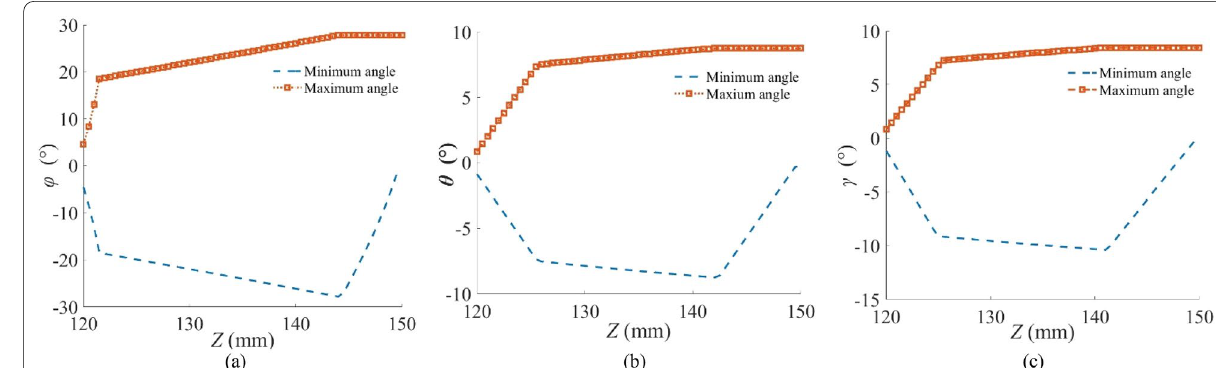
Figure 16 Pose angle to Z : a φ to Z , b θ to Z , c γ to Z